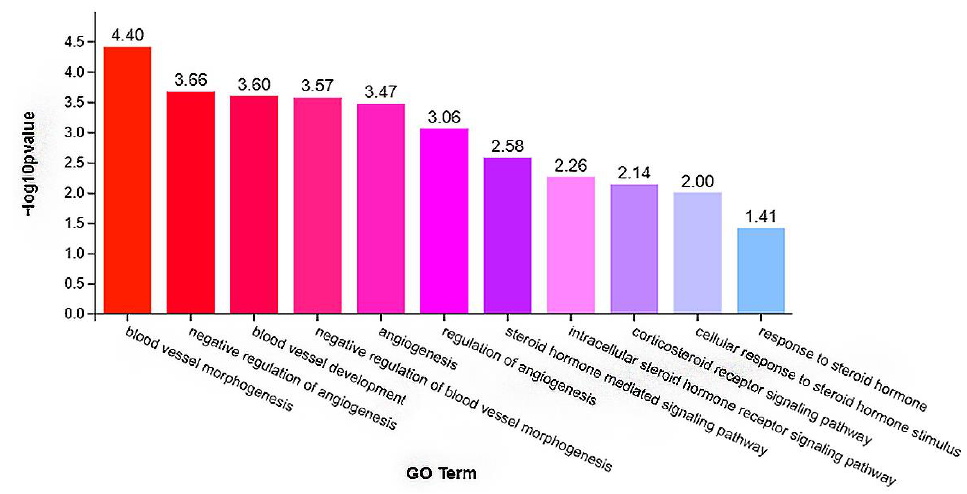
Figure 3. Gene ontology (GO) terms related to steroid hormone synthesis and angiogenes.